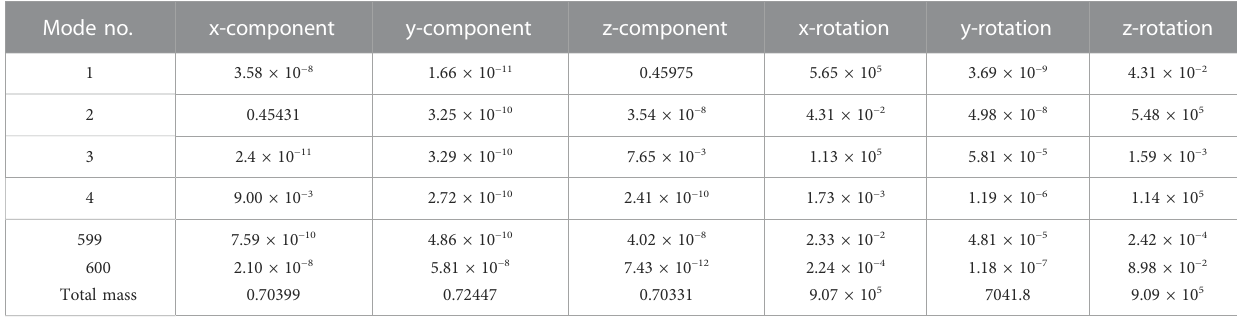
TABLE 6 Effective mass of conventional column. Mode no.